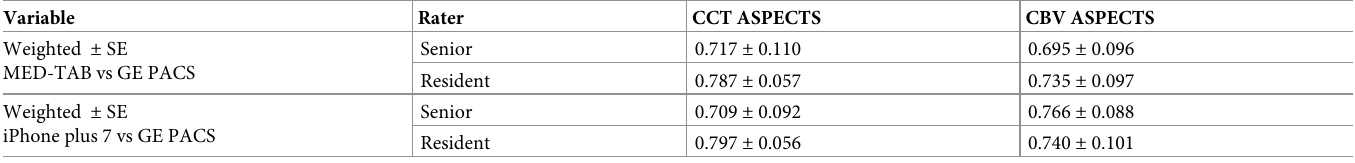
Table 4. Intrarater agreement for CCT and CBV ASPECTS between MED-TAB/iPhone plus 7 and GE PACS.